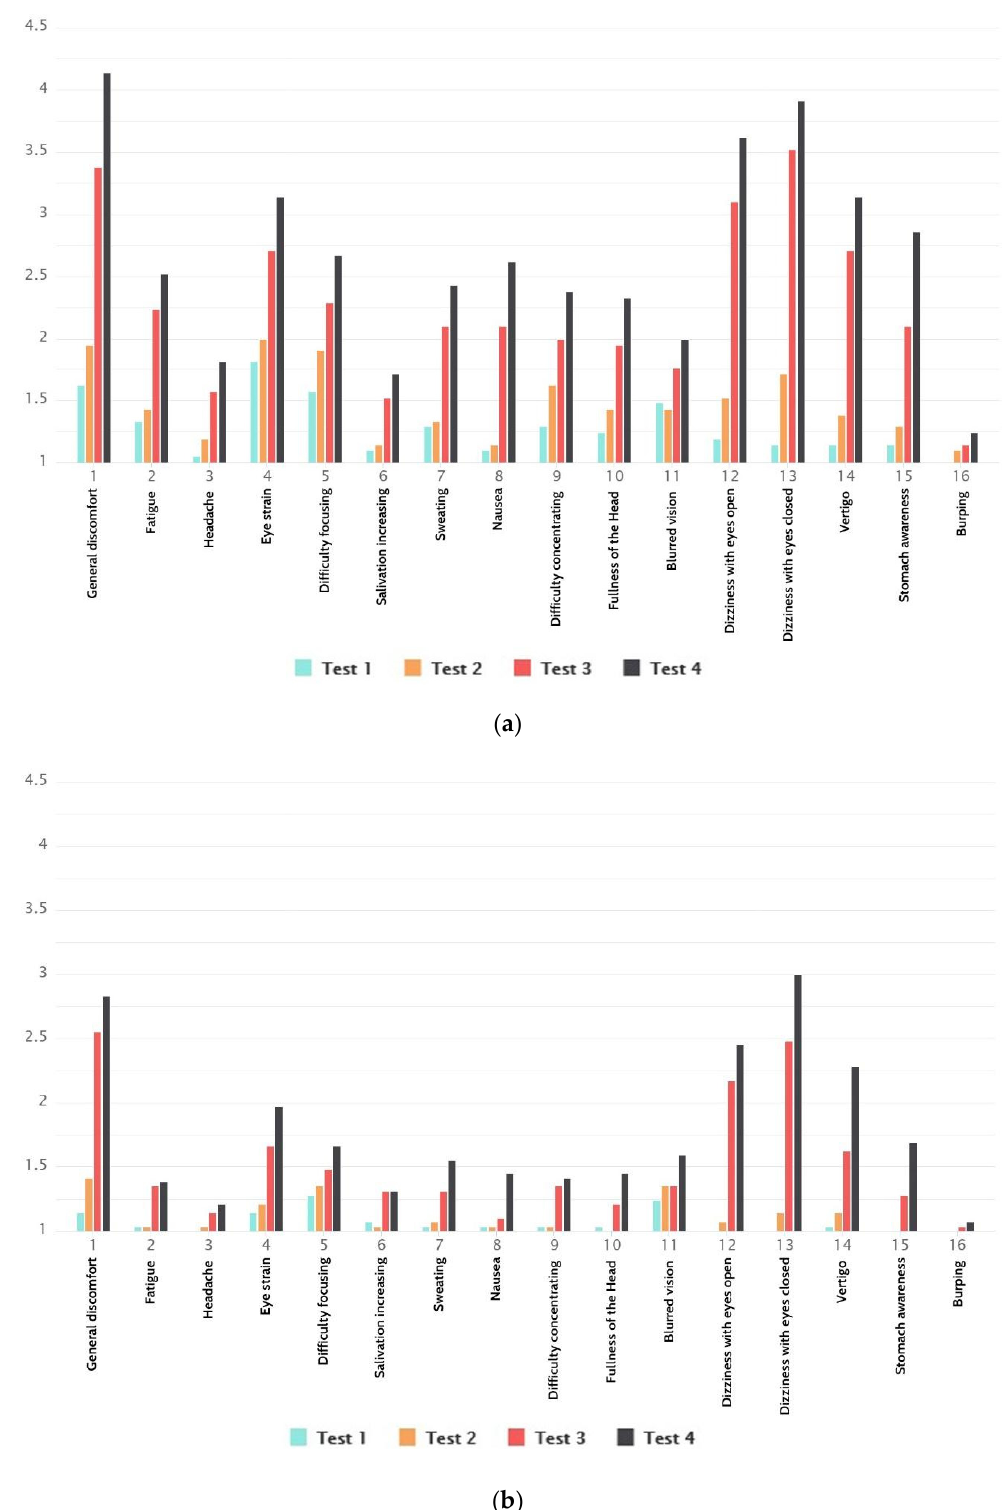
Figure 10. ( a ) Total SSQ results for women. ( b ) Total SSQ results for men.